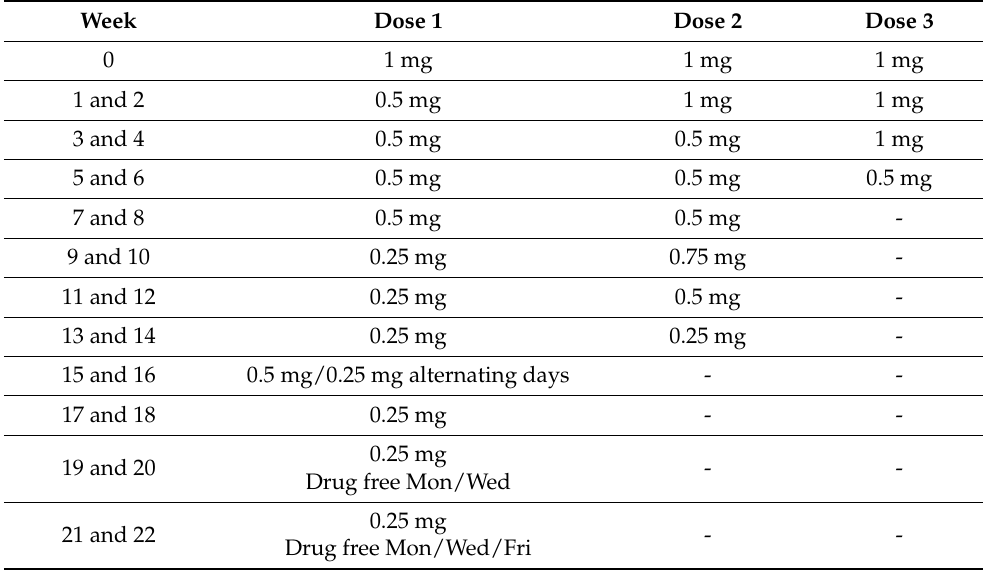
Table 2. Lorazepam